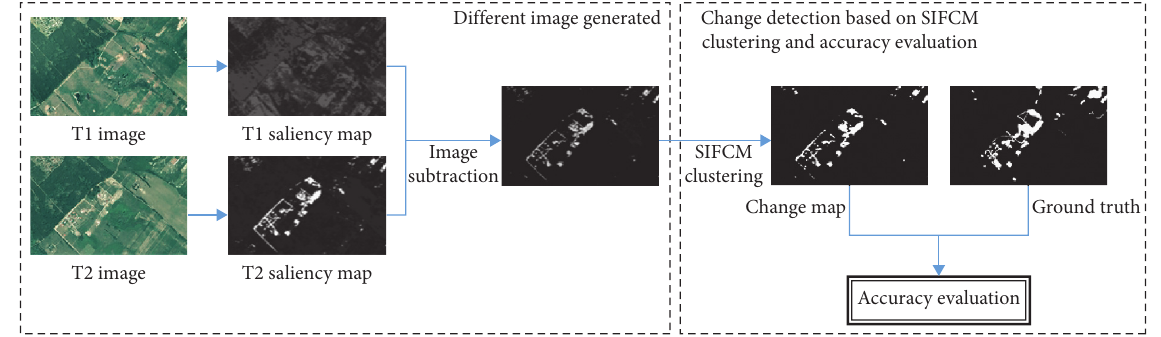
Figure 1: Flow chart of the proposed